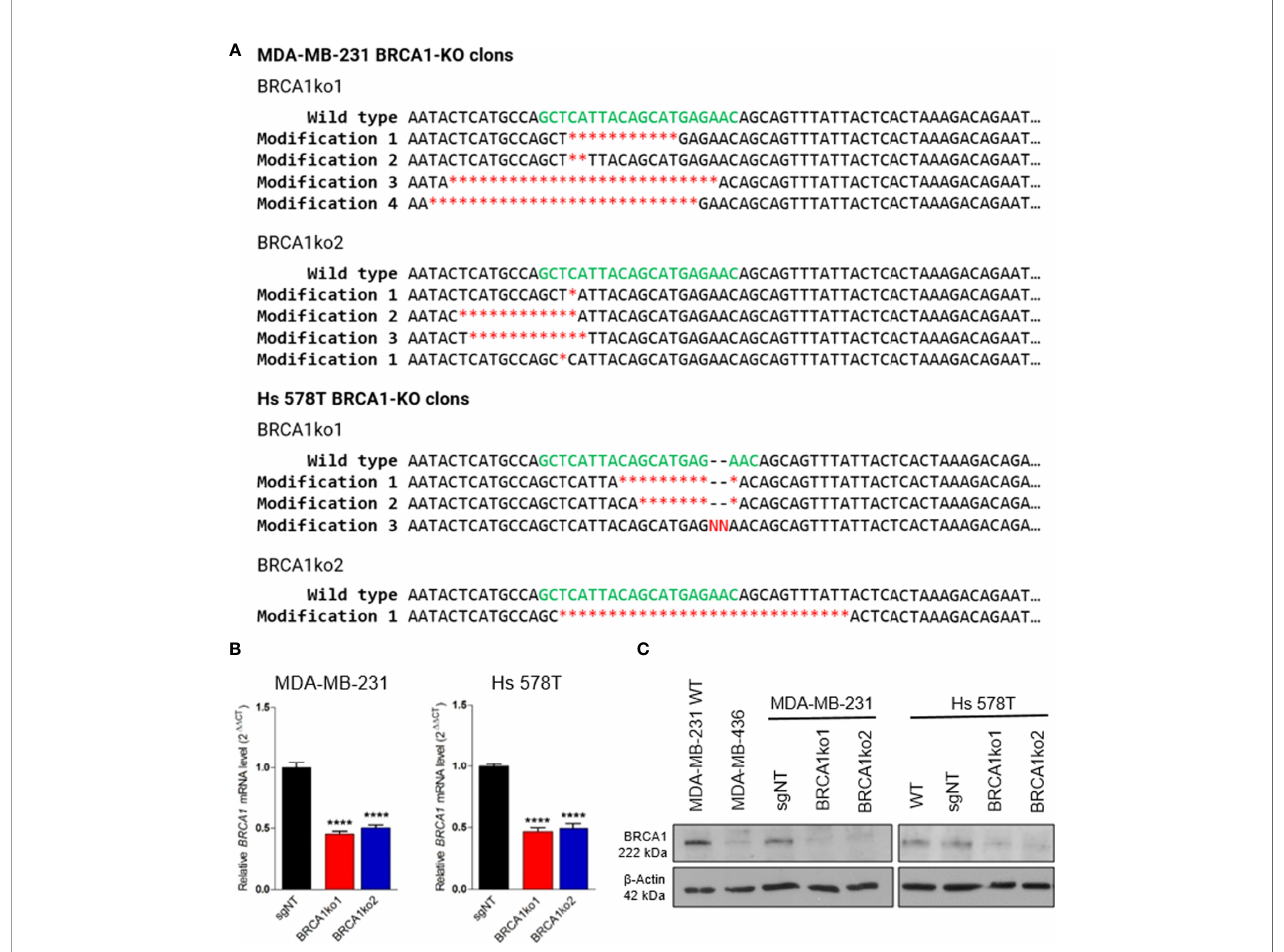
FIGURE 1 | Validation of BRCA1 knockout in BRCA-KO clones. (A) Deleted and inserted nucleotides in BRCA1 -KO clones giving rise to premature termination codons in the BRCA1 open reading frame. Sequences of guide RNA are indicated in green letters and red indicate nucleotide deletions (*) or insertions (N). (B) BRCA1 mRNA relative level in parental non-targeting control TNBC cells (sgNT), and two BRCA1 -KO clones (BRCA1ko1 and BRCA1ko2). (C) Western blotting of BRCA1. b -actin was used as a loading control. Unpaired t ‐ tests were used in (B) . Bars show the mean and the SEM of three independent experiments. *p- value<0.05; **p-value<0.01; ***p-value<0.001 and